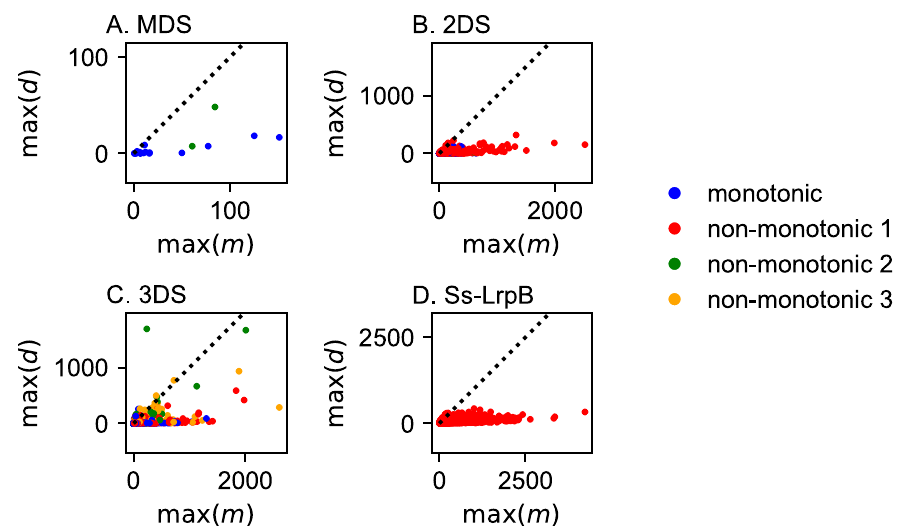
Fig 5. Amplitudes of oscillation in the monomer (m)—dimer (d) plane for the different toy models. The dashed line represents same copy number of monomer and dimer. Oscillations for the MDS are small: the dimer copy number does not exceed 50. The copy number of the monomer is higher than the copy number of the dimer for the majority of the solutions for all systems, contrarily to what is observed in prokaryotic systems in nature.